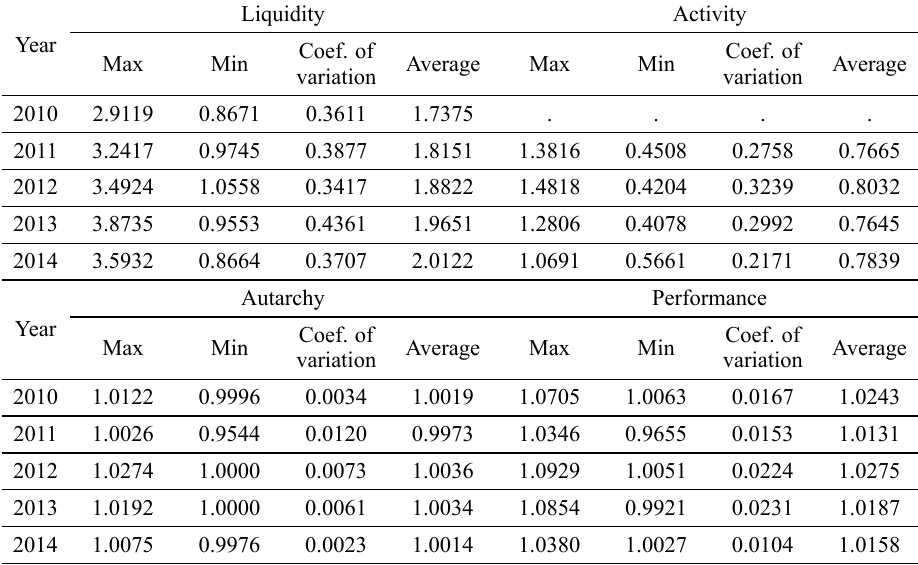
Coef. of Average variation